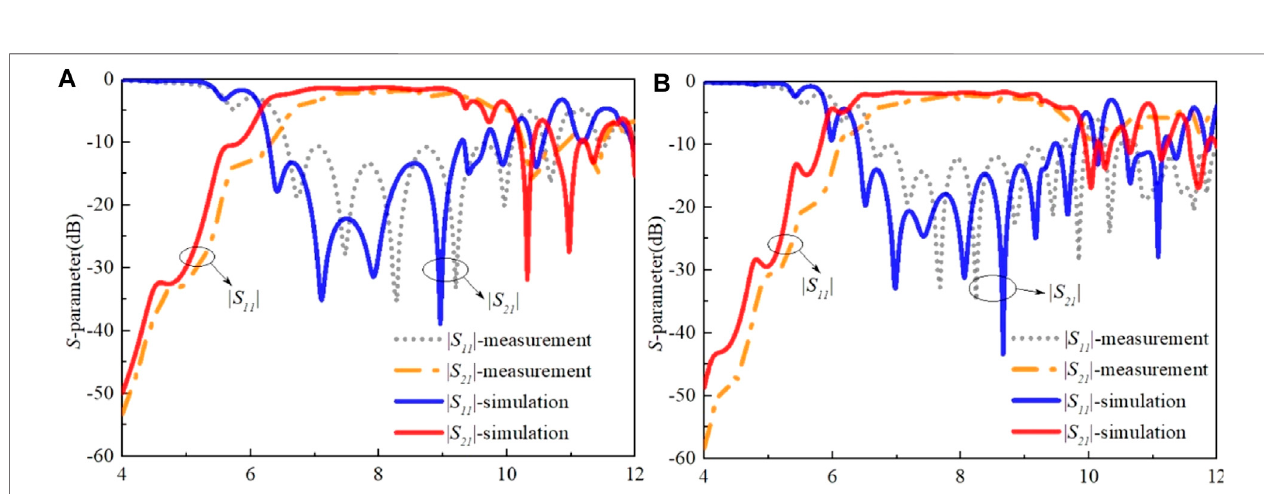
FIGURE 3 | (A) Photograph of two structures with different lengths of DRW. (B) Assembly of the 50-mm-long dielectric rod waveguide and the conversion structure.